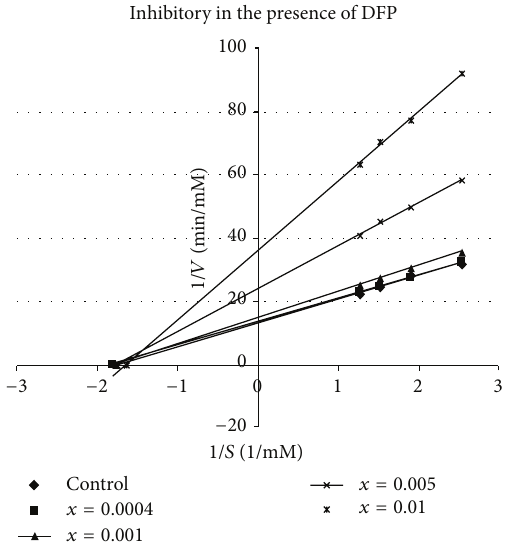
Figure 3: Determination of apparent kinetic parameters ( 𝐾 app 𝑚 , 𝑉 󸀠 𝑚 ) for DFP.